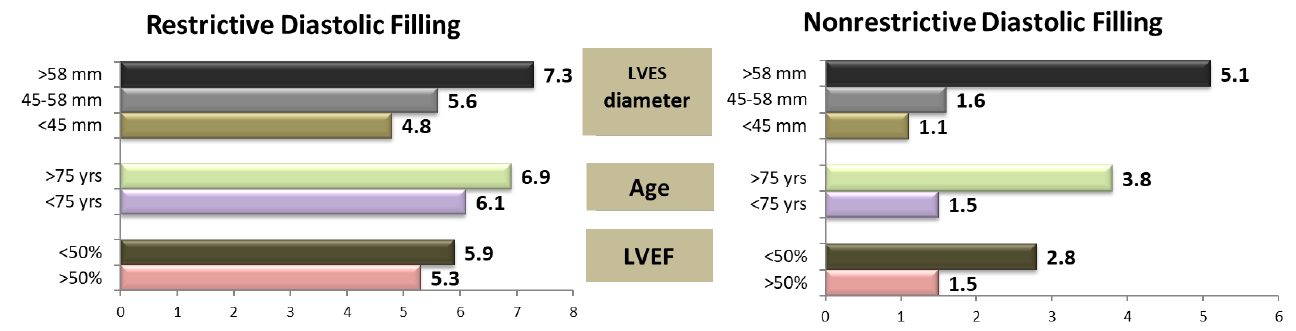
Figure 2. Early postoperative risk of death in patients with AVR depending on the type of LVDFP. LVEF—left ventricle ejection fraction; LVES—left ventricle